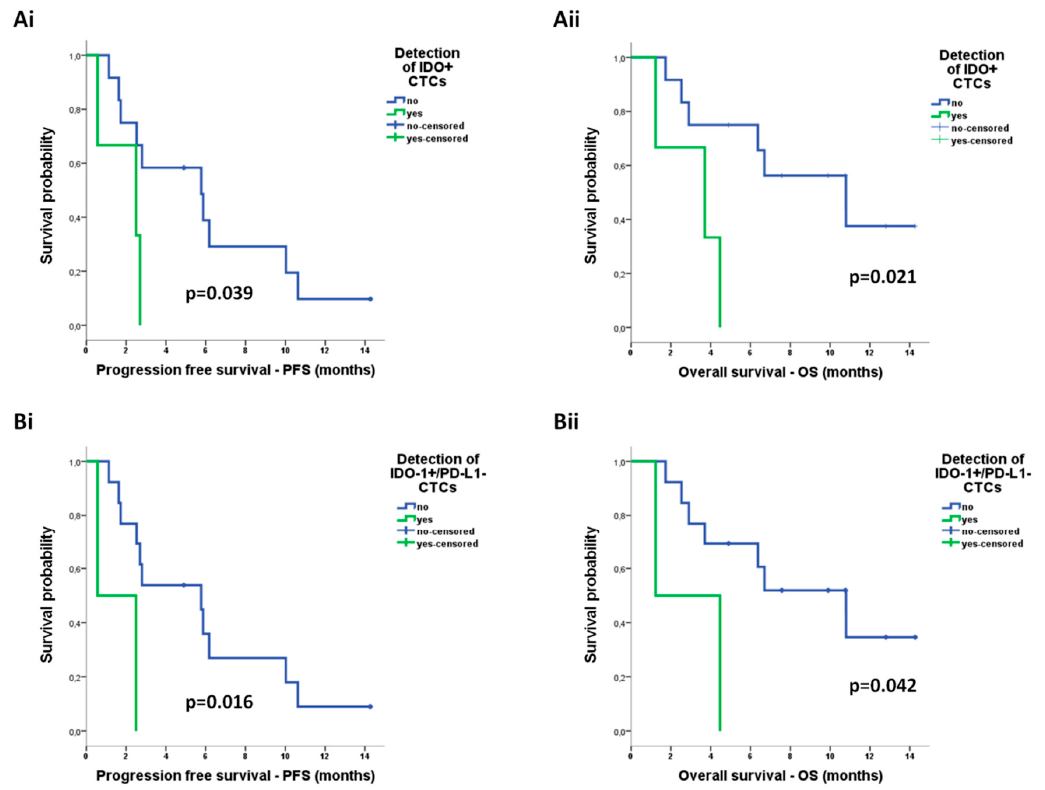
Figure 7. Prognostic relevance of distinct circulating tumor cell (CTC) populations enriched by Parsortix in patients with non ‐ small cell lung cancer (NSCLC): Kaplan–Meier analysis of progression ‐ free survival (PFS) and overall survival (OS) according to the detection of ( Ai,ii ) CTCs positive for indoleamine ‐ 2,3 ‐ dioxygenase (IDO) expression and ( Bi,ii ) CTCs positive for IDO but negative for programmed cell death ligand ‐ 1 (PD ‐ L1) expression (IDO+/PD ‐ L1 − phenotype). Table 4. Univariate Cox ‐ regression analysis for PFS and OS among patients with NSCLC.